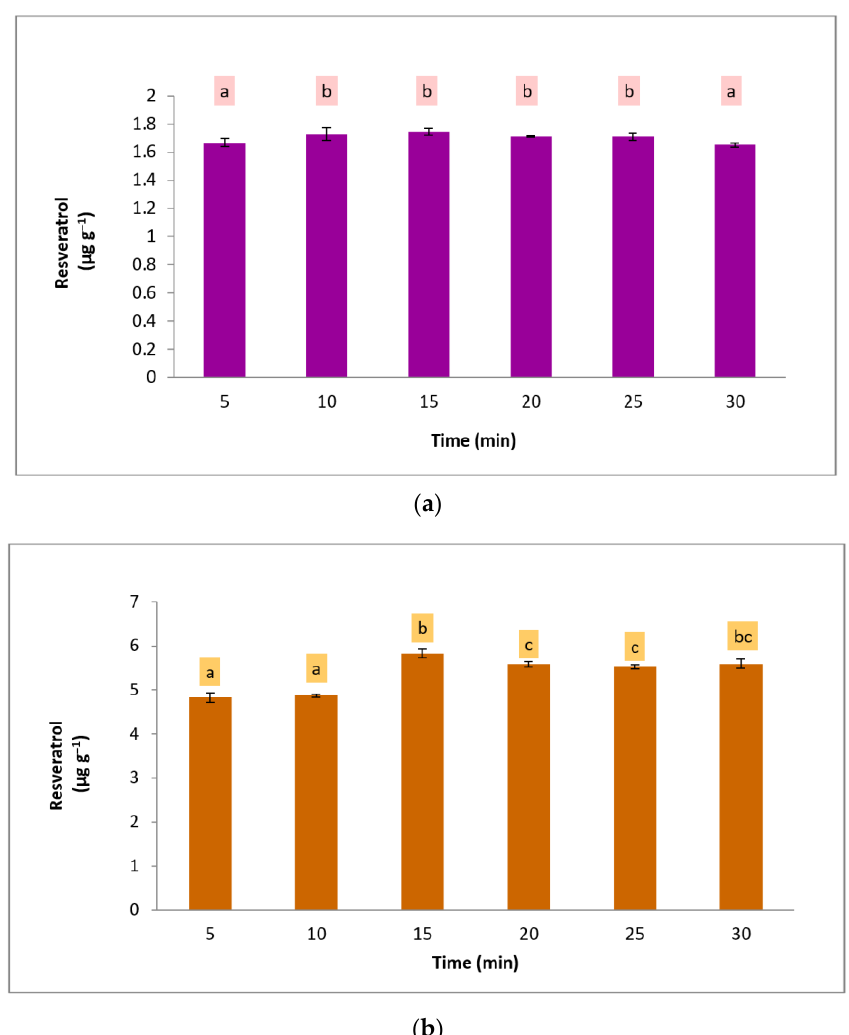
Figure 4. The optimized MAE condition in different extraction times for extracting resveratrol from ( a ) marmalade and ( b ) cookie samples. Different letters in the bars mean significant differences (95% confidence level).